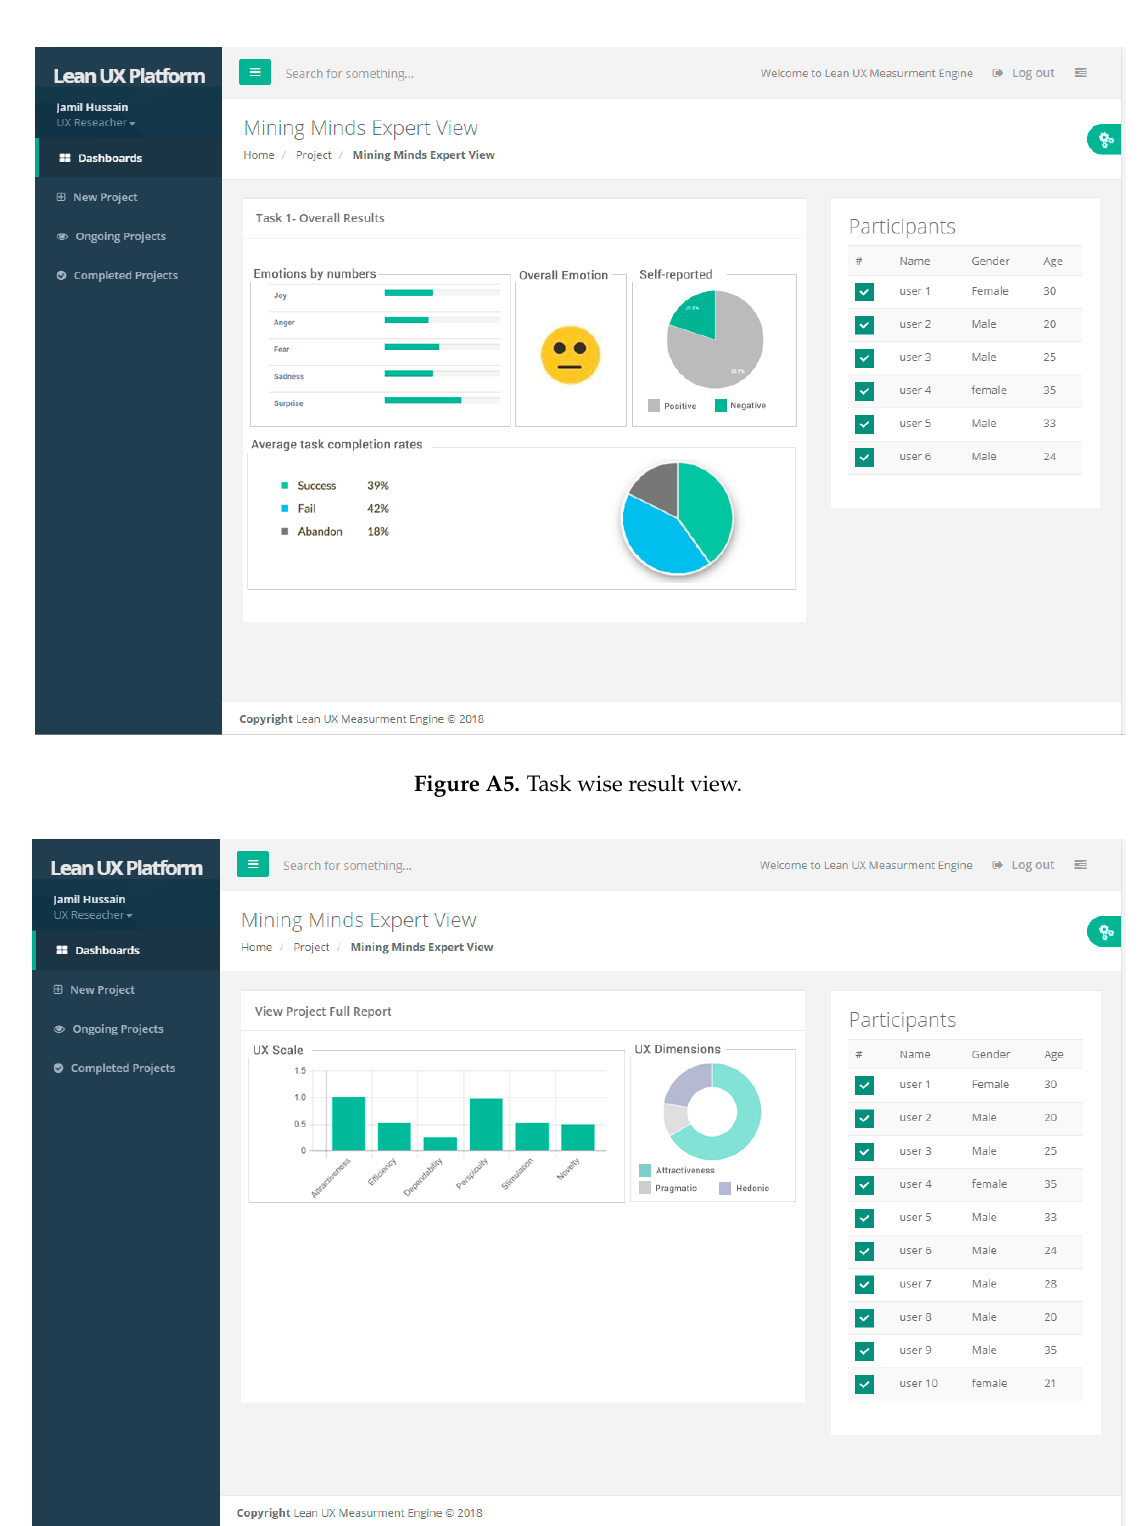
Figure A6. Project wise result view.